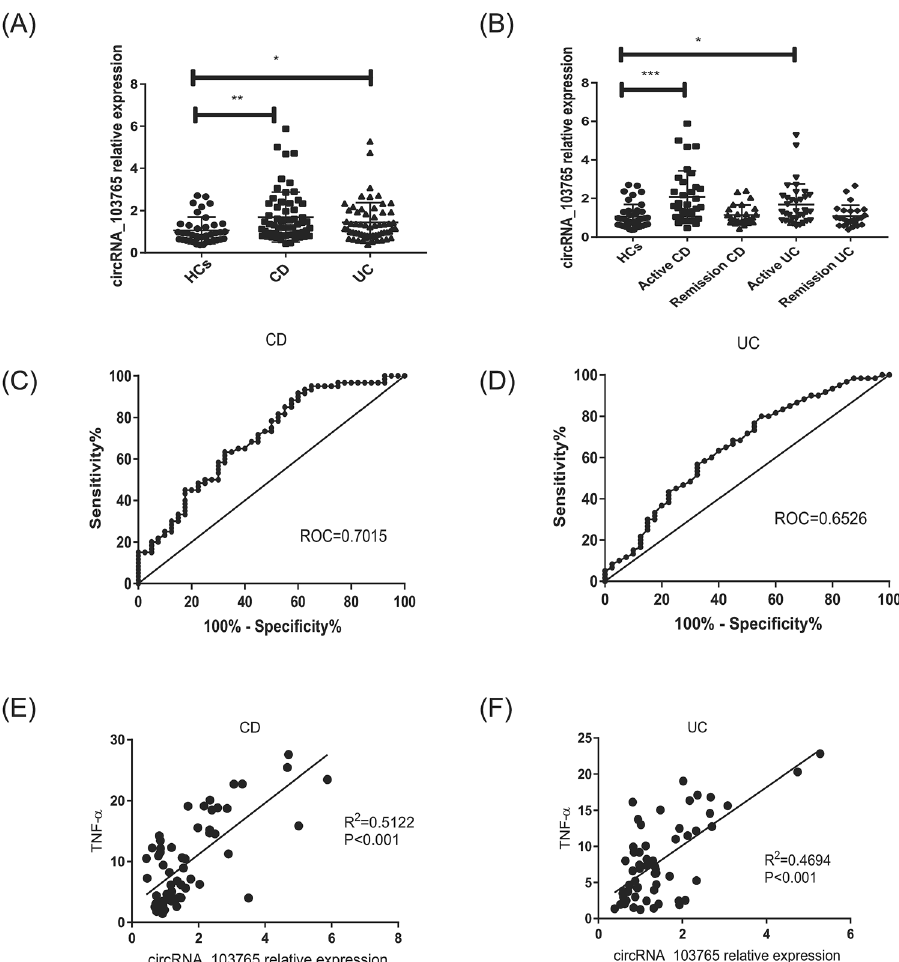
Figure 1. CircRNA_103765 is highly increased in peripheral blood mononuclear cells (PBMC) of patients with IBD. ( A ) qRT-PCR analysis of circRNA_103765 in PBMC from healthy controls (HCs) (n = 40), patients with Crohn’s disease (CD) (n = 60), patients with ulcerative colitis (UC) (n = 60). ( B ) qRT-PCR analysis of circRNA_103765 in PBMC from HC (n = 40), active CD patients (n = 34), CD patients in remission (n = 26), active UC patients (n = 35), UC patients in remission (n = 25). ( C , D) Receiver operating characteristic analysis (ROC) of circRNA_103765 in patients with CD and UC. ( E , F ) Correlations of circRNA_103765 expression